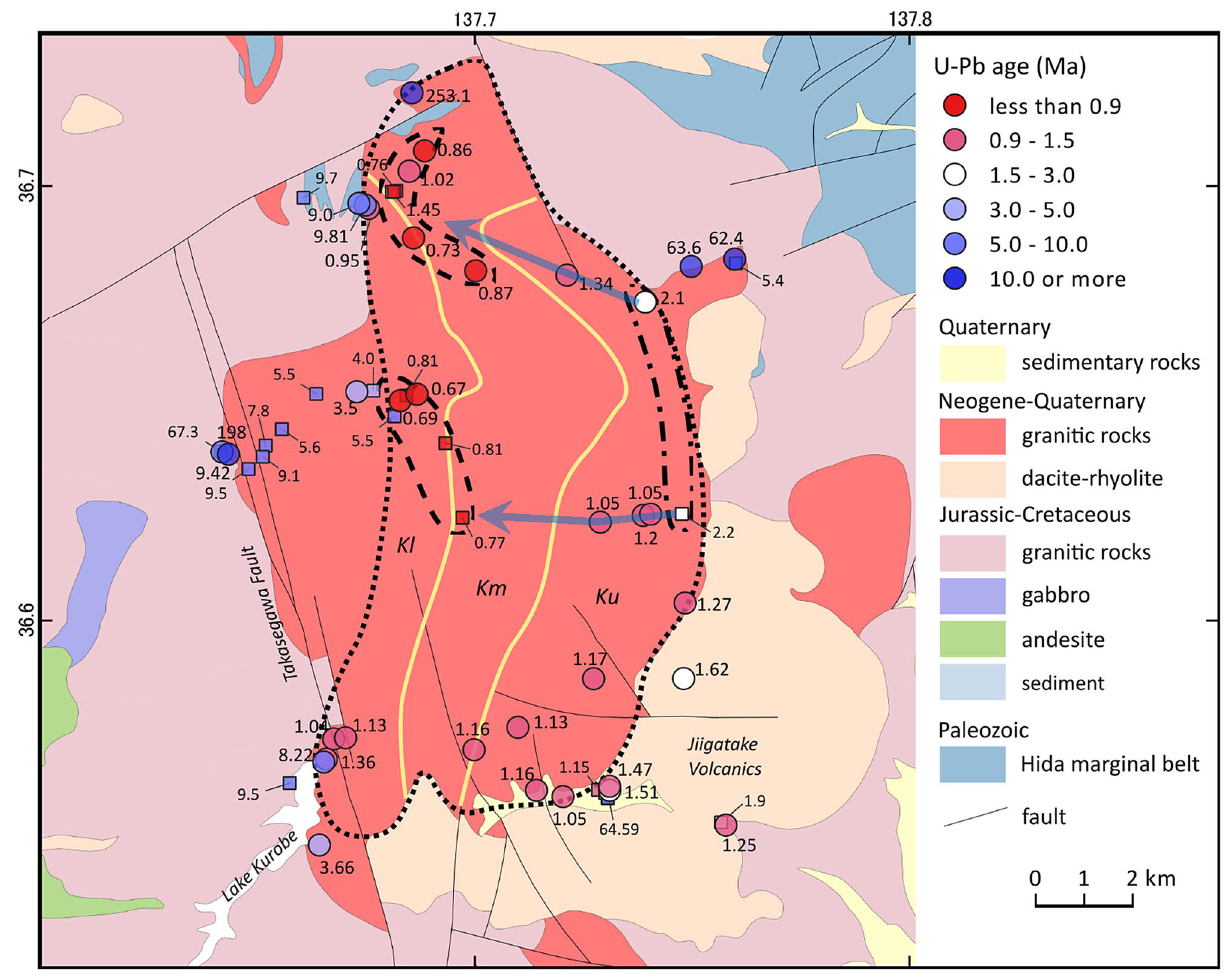
Figure 2. Geological map of the area surrounding the Kurobegawa Granite, showing the sample locations and zircon U–Pb ages. Dotted area denotes the Quaternary Kurobegawa Granite including ~ 2 Ma portion. Large circles and small squares are ages in this study and the literature 16–18 , respectively. Dashed and dash-dot areas are youngest (< 1.0 Ma) and oldest (> 2.0 Ma) portions, respectively. Two blue lines indicate the granite becomes younger to the west. The three lithological units (upper, middle, and lower shown as Ku, Km, and Kl, respectively) of Wada et al. 23 is delineated by yellow lines. Hida marginal belt comprises ultramafic